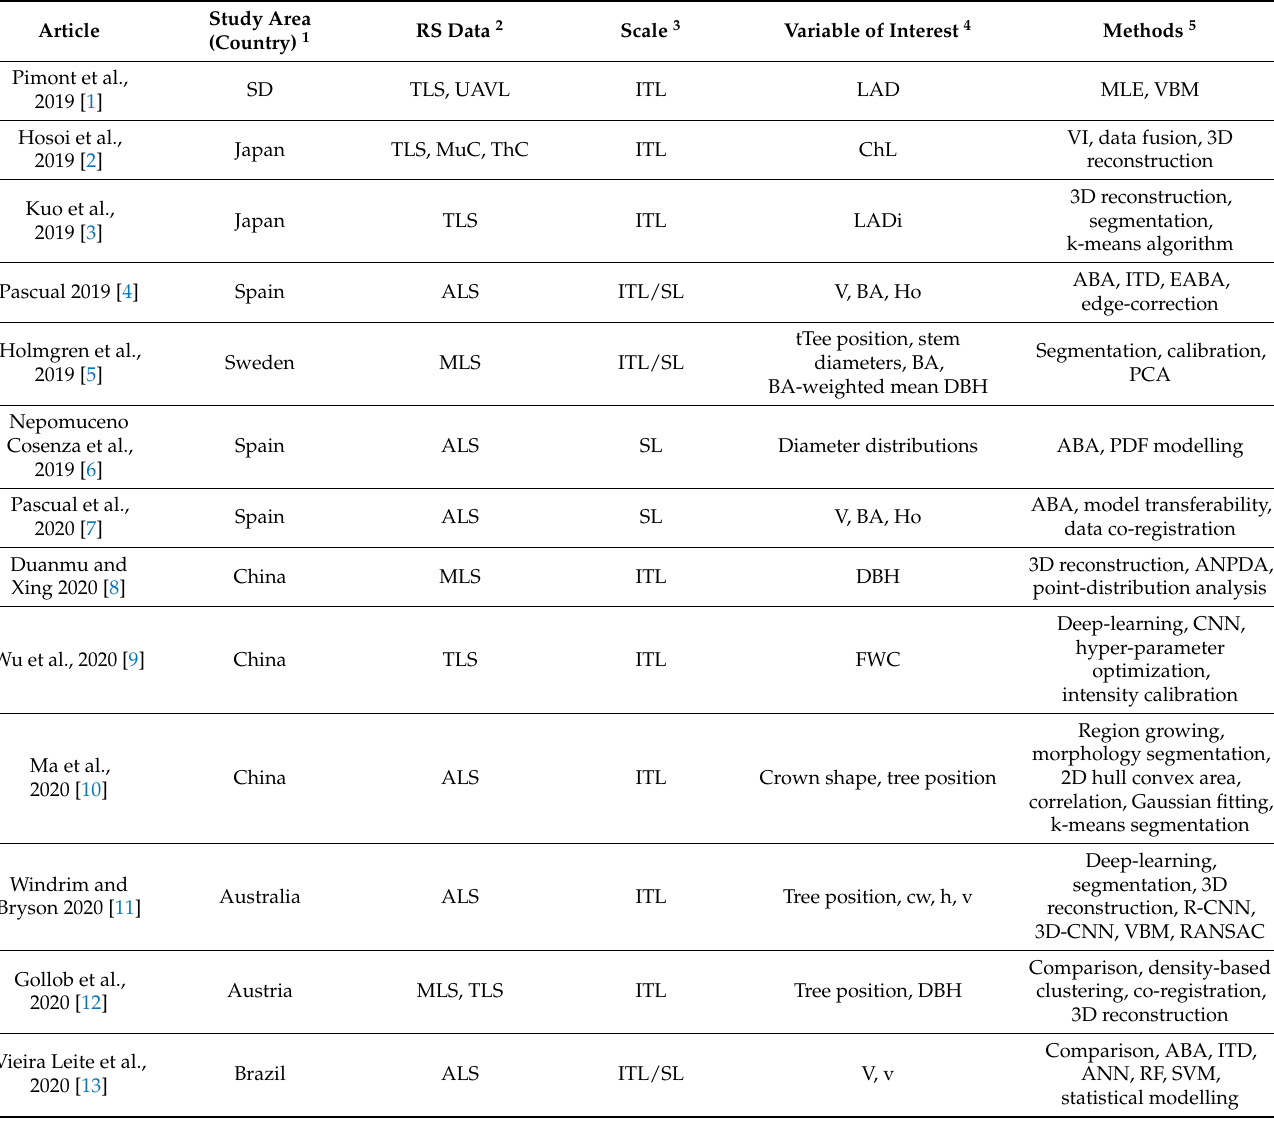
Table 1. Overview of the research articles included in the Special Issue “3D Point Clouds in Forest Remote Sensing” in the journal Remote